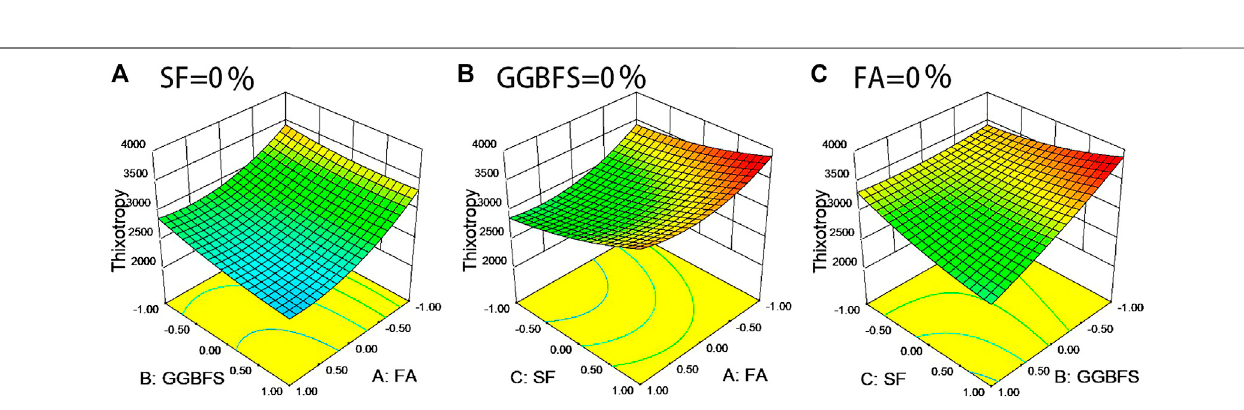
FIGURE 11 | The combined effect of SCMs on thixotropy of nano-silica modi fi ed cement-based paste.